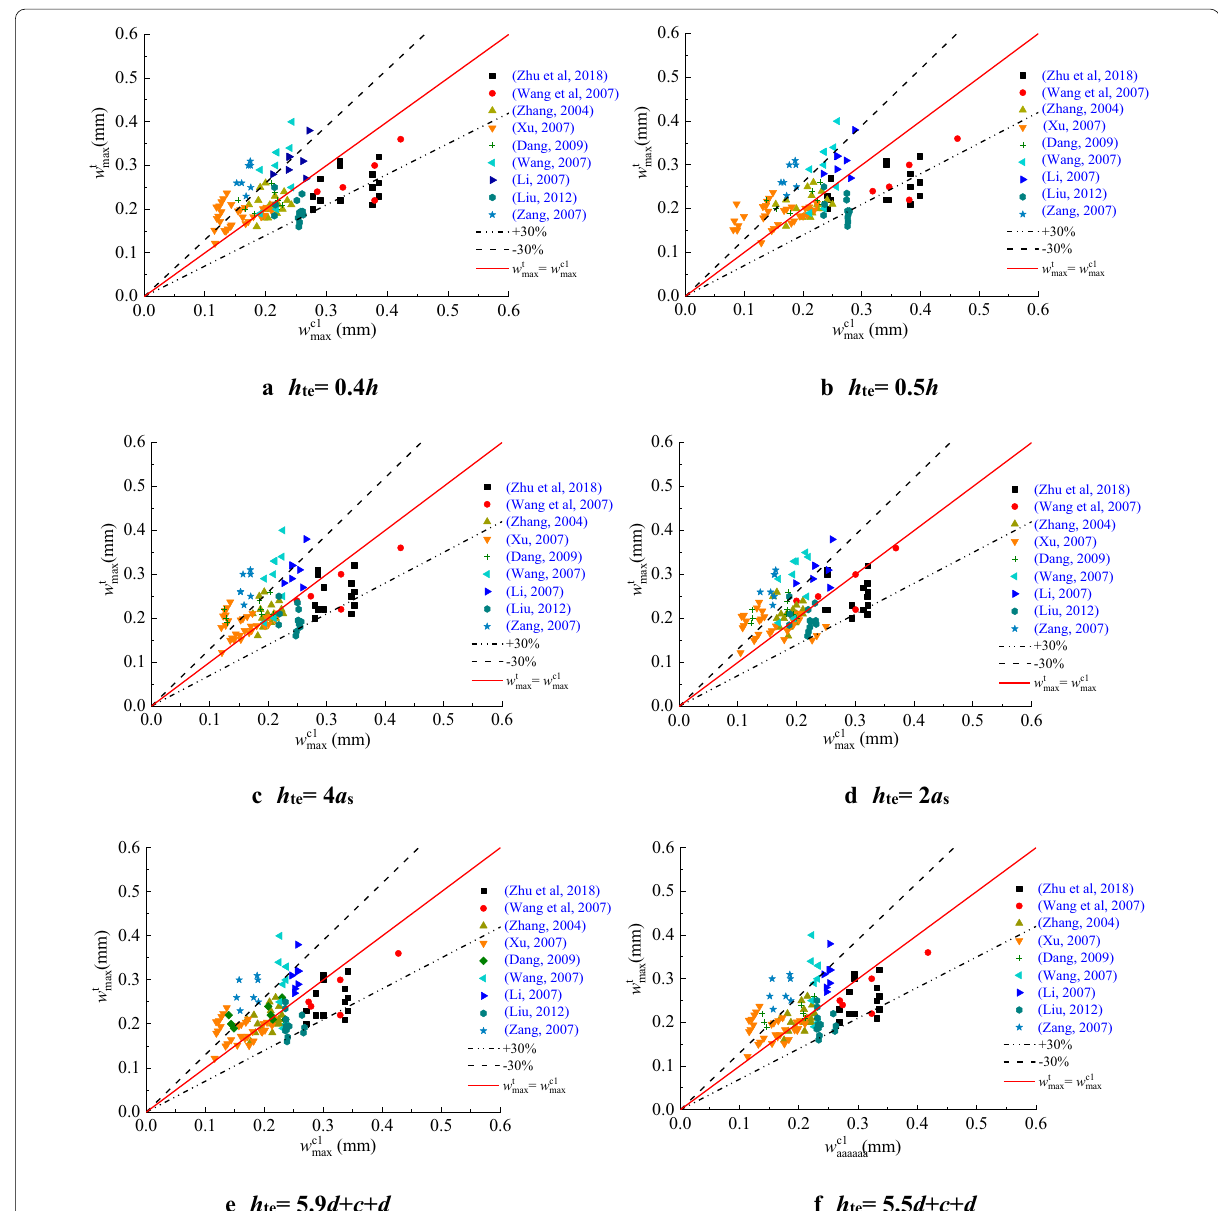
Fig. 17 Comparison of experimental w t max from RC beams with 500 MPa steel bars with calculated w c1 max by the proposed